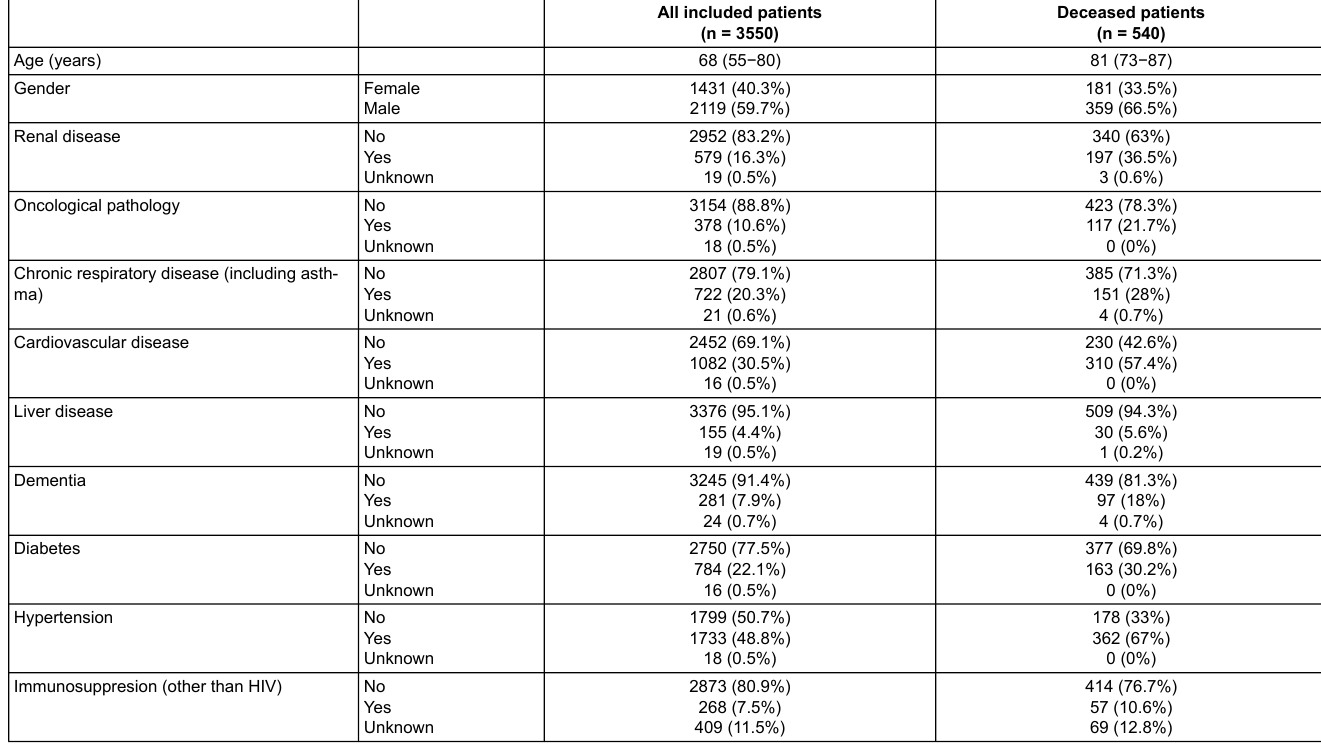
Table S2: Characteristics of all patients and deceased